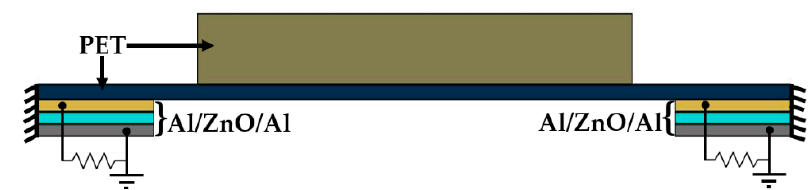
Figure 8. Schematic view of the electrical connection of the load resistance between the upper and lower electrodes of the piezoelectric nanogenerator.